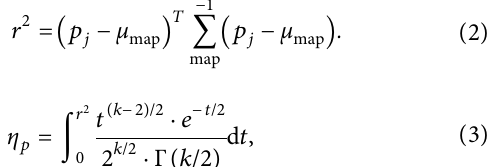
Figure 5: Map change inference by ray-casting.